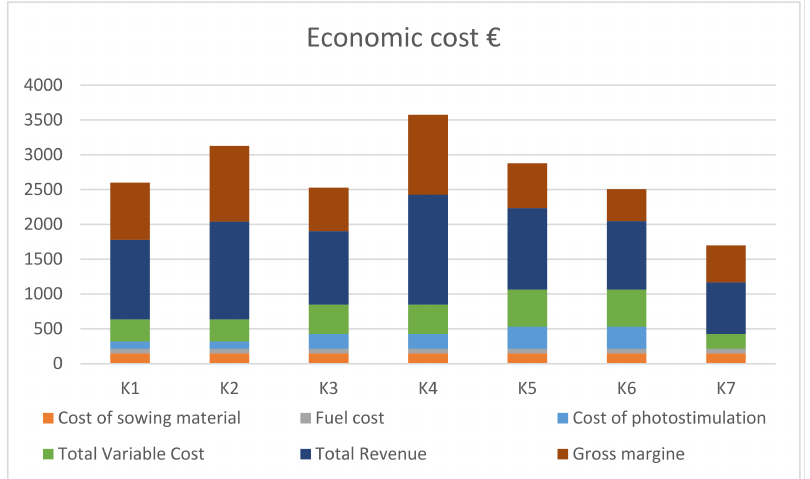
Figure 7. Average gross margin and variable costs (EUR ha − 1 year − 1 ) of soybean with (K1–K6) and without (K7)